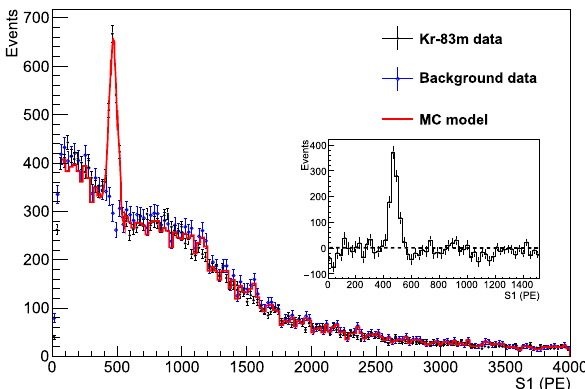
Fig. 13 Measured S1 distribution from a 83 m Kr calibration run with = 183 V/cm, superimposed with the normalised environmental E d background and the best fit to a template (Monte Carlo signal + back- ground data) that accounts for detector resolution. The inset shows the background-subtracted spectrum